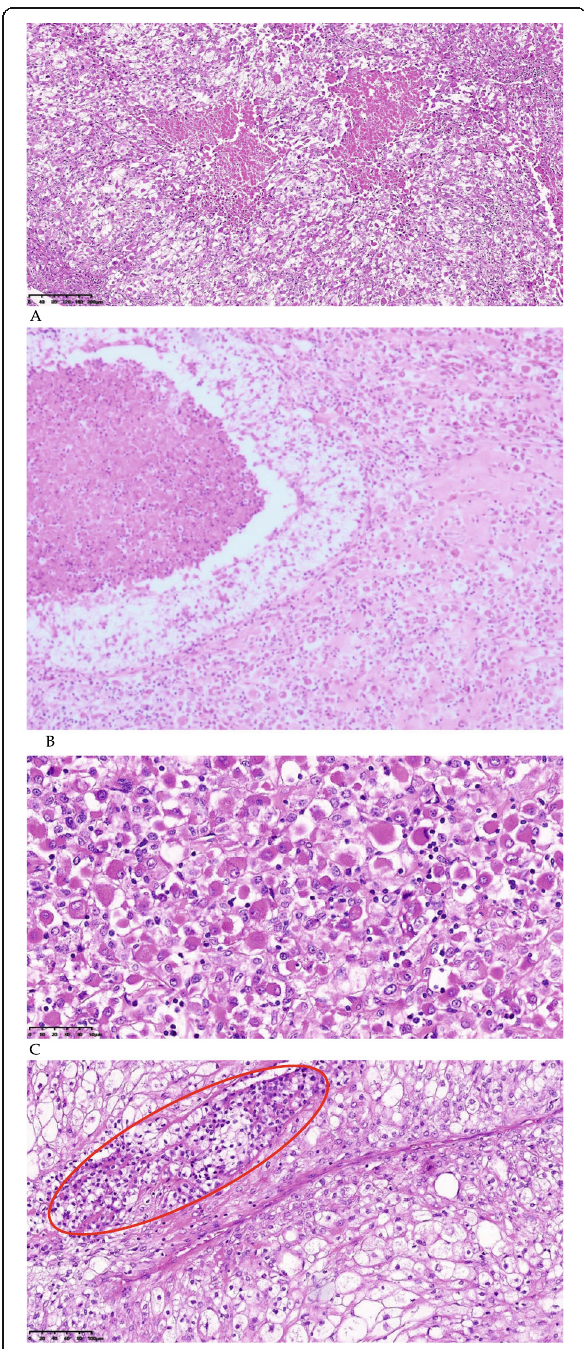
Fig. 4 a Tumor cells with clear cytoplasm and rhabdomyoid tumor cells with eosinophilic nuclei intermingled with diffuse patchy arrangement and necrosis in the center [hematoxylin and eosin (HE) 100×]. b Junction between the typical parathyroid carcinoma cell region and the differentiated cell region of rhabdoid sarcoma (HE, 50×). c Rhabdoid tumor cells, eosinophilic cytoplasm, nuclear deviation, and obvious nucleolus (HE, 400×). d obvious characteristics of parathyroid glands: small cubic clear cells, abundant slender fibrovascular compartments (inside the red oval).(HE,